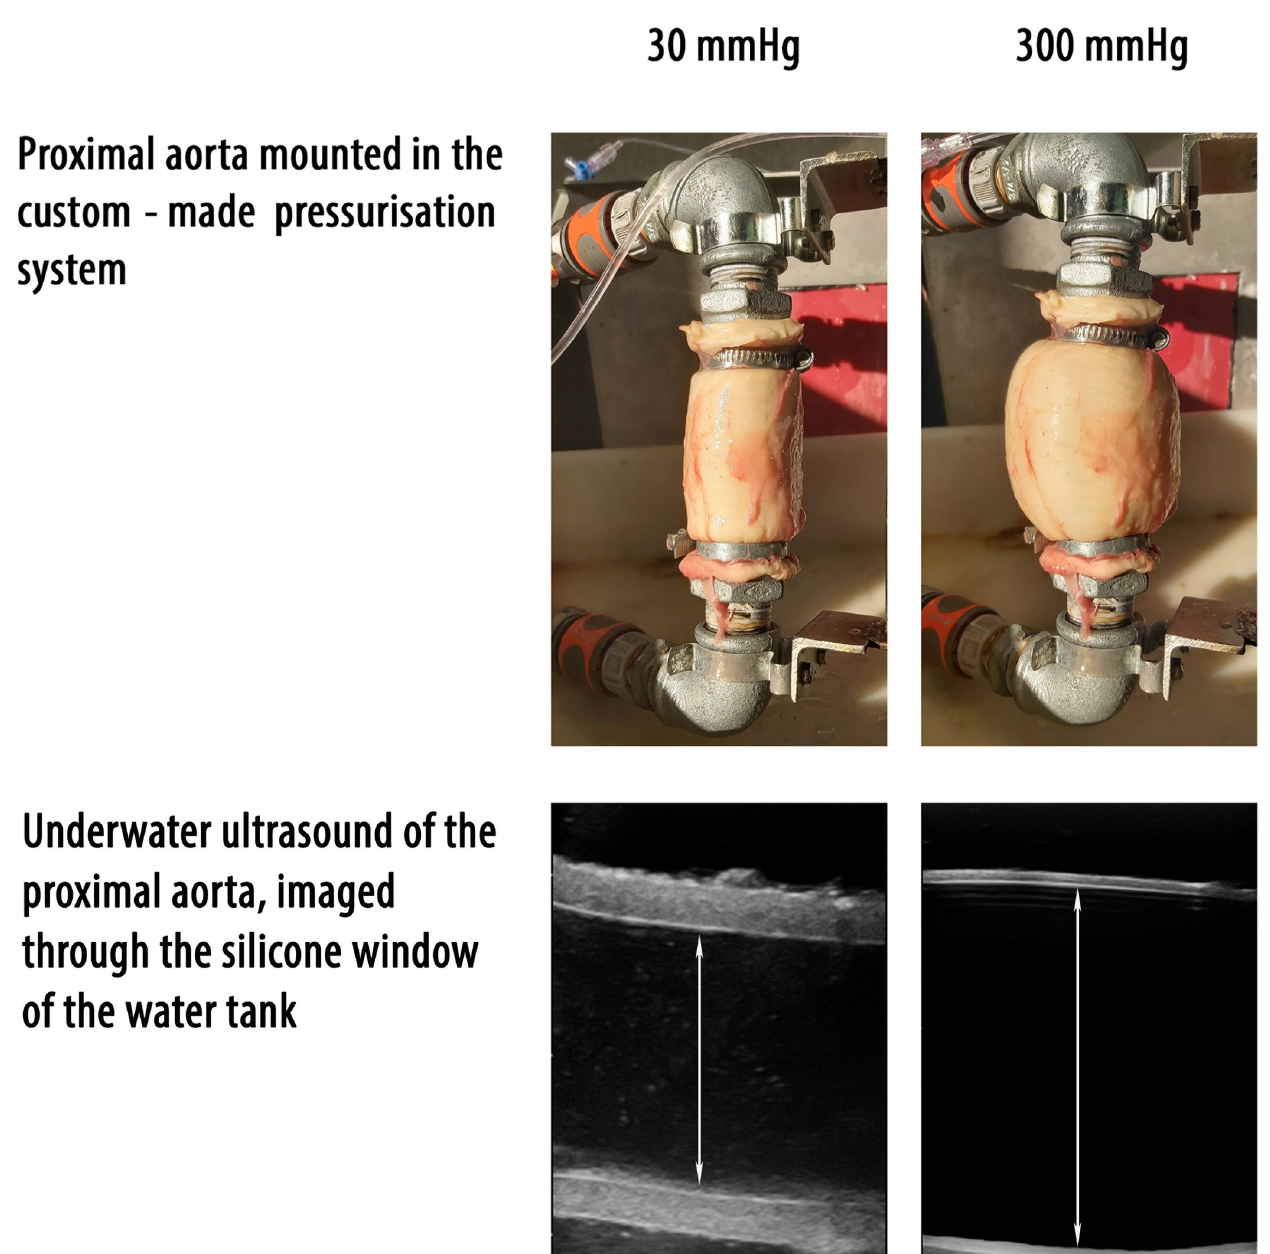
Fig 3. Example of the proximal aorta, mounted in the pressurisation system but out of the water bath, and derived ultrasound images at 30 (left) and 300 (right) mmHg. Double-sided arrows indicate diameter measurements performed from inner edge to inner edge. Inflation-extension test. Statistical analysis was performed using R version 3.2.6 and Matlab. For the inflation—extension test, results were fitted to the arctangent model of Langewou-